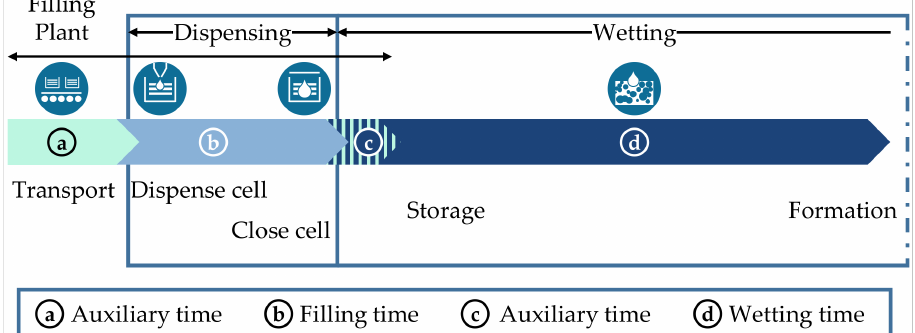
Figure 1. Schematic illustration of the electrolyte filling process with its